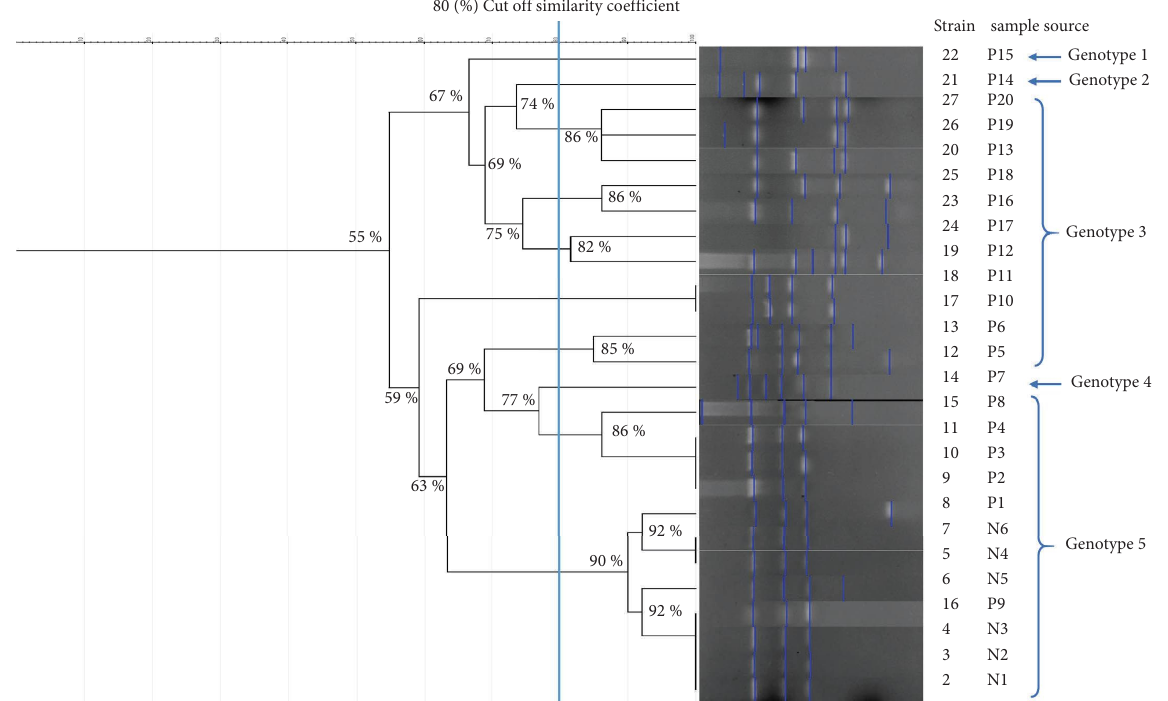
Figure 3: Te banding pattern of 26 A. baumannii strains isolated from the ICU environment and COVID-19 individuals is shown in a dendrogram obtained from ERIC-PCR. P : patient, N : nosocomial (ICU Table 3: Te genotypic pattern of 26 A. baumannii strains isolated from the ICU environment and severely ill COVID-19 patients. Strain number